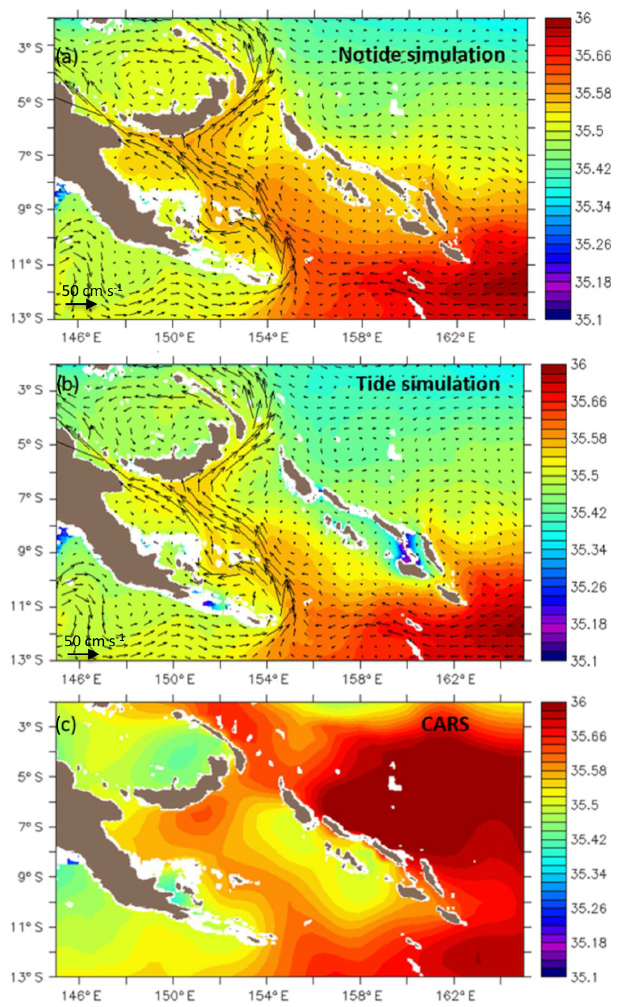
Figure 12. Mean salinity distribution (in color) and mean circu- lation (arrows) of the UTW waters from the 3-year (a) NOTIDE simulation, (b) TIDE simulation, and (c) the multidecadal CARS climatology. Isobathymetric lines are from the NOAA/ETOPO2v2 bathymetric file from the Smith & Sandwell database (https://doi. org/10.7289/V5J1012Q, National Geophysical Data Center, 2006). White color is for bathymetry of less than